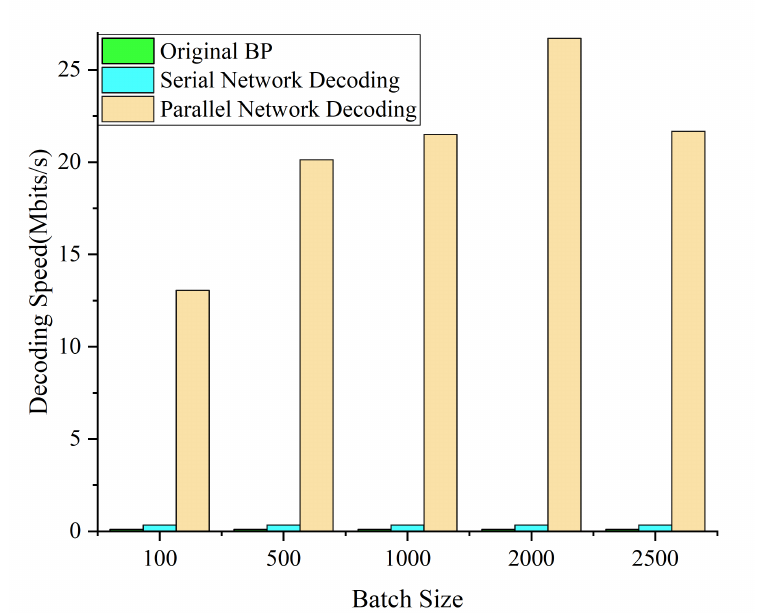
Figure 9. The decoding speed of different decoding implementation methods. The speed of serial network decoding reaches 0.339 Mbits/s, which is already better than the original BP algorithm. The speed of parallel network decoding even reaches 26.7 Mbits/s on an NVIDIA GeForce GTX 1650